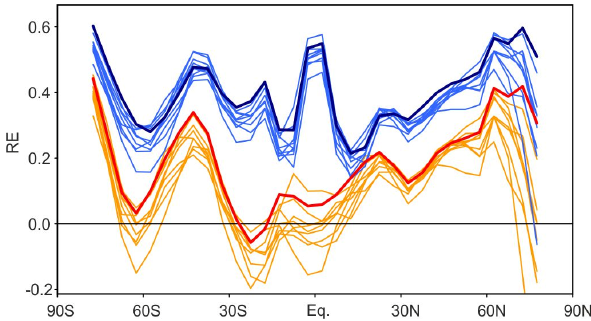
Fig. 6. RE values for zonal mean total column ozone (monthly Figure 6. RE values for zonal mean total column ozone (monthly means) derived from comparing HISTOZ.1.0 means) derived from comparing HISTOZ.1.0 with TOMS. Thick with TOMS. Thick lines are for the ensemble mean, thin line for the members. Blue refers to x 0 = climatology of lines are for the ensemble mean, thin line for the members. Blue x b , orange refers to x 0 = = x b . refers to x 0 = climatology of x b , orange refers to x 0 = x b